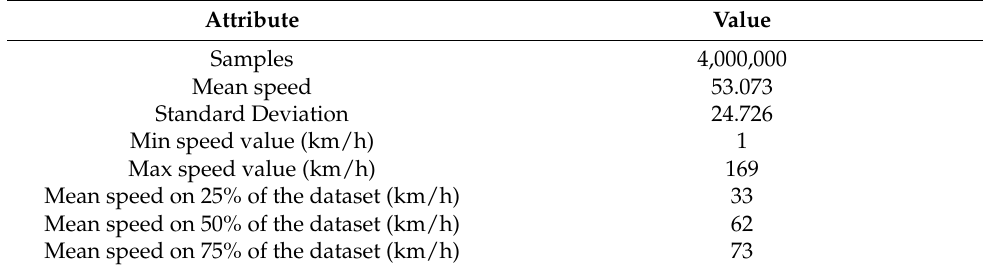
Table 3. Dataset attributes summary.